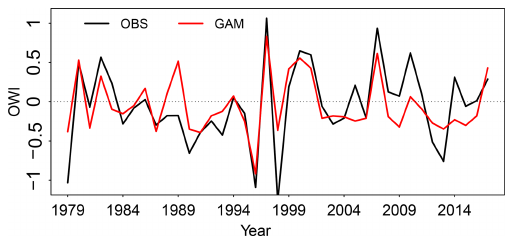
Figure 11. The variation in the observational OWI (black) and the fitted OWI by the generalized additive model (GAM; red) from 1979 to